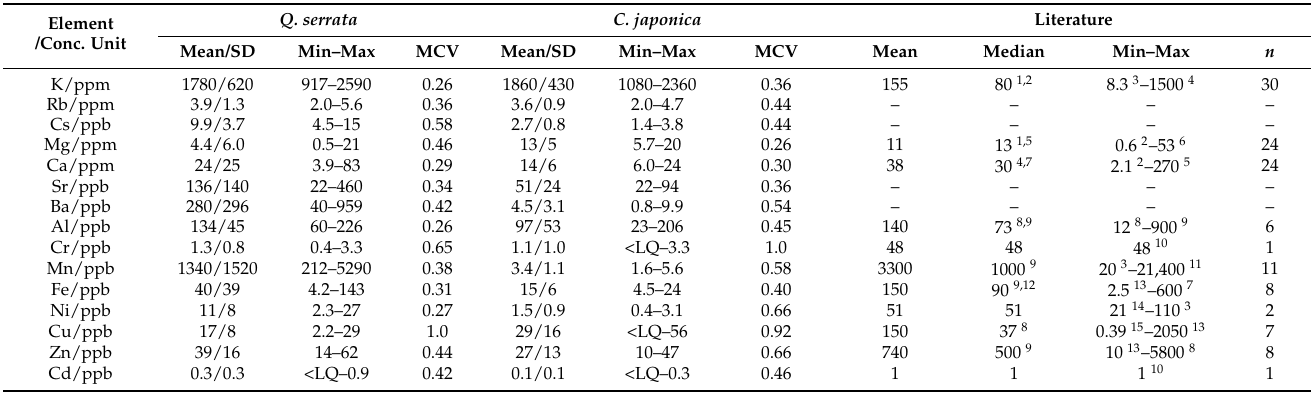
Table 2. Concentrations of metallic elements in the xylem sap obtained in Experiment 3 and those reported in the